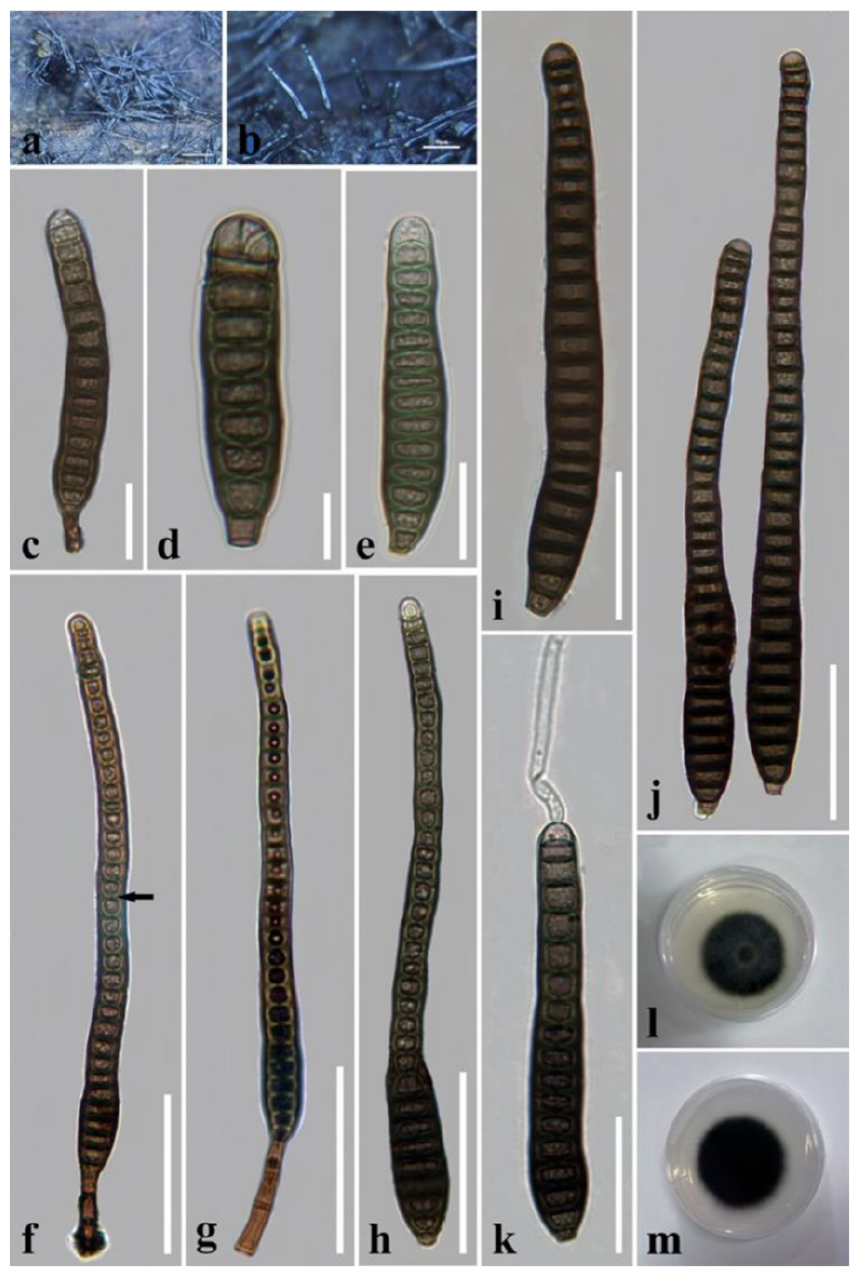
Figure 15. Distoseptispora tectonae . ( a , b ) Colonies on natural substrate. ( c , f , g ) Conidiophores with conidia. The arrow in f points to a gap in the middle of the septum, which indicates the distosepta. ( d , e , h – j ) Conidia. ( k ) Germinated conidium. ( l ) Colony on PDA (from front). ( m ) Colony on PDA (from reverse). Scale bars: ( c , e ) 20 µ m; ( d ) 10 µ m; ( f – h ) 50 µ m; ( i , k ) 30 µ m; ( j ) 40 µ